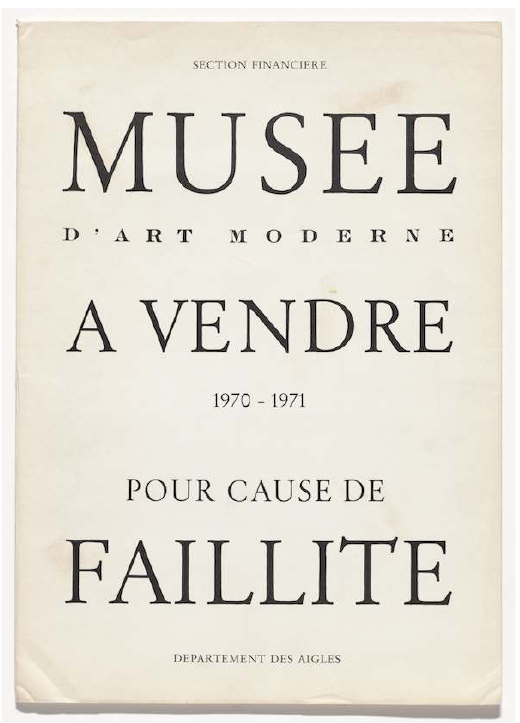
© 2016 Estate of Marcel Broodthaers / Artists Rights Society (ARS), New York / SABAM, Brussels. Source: